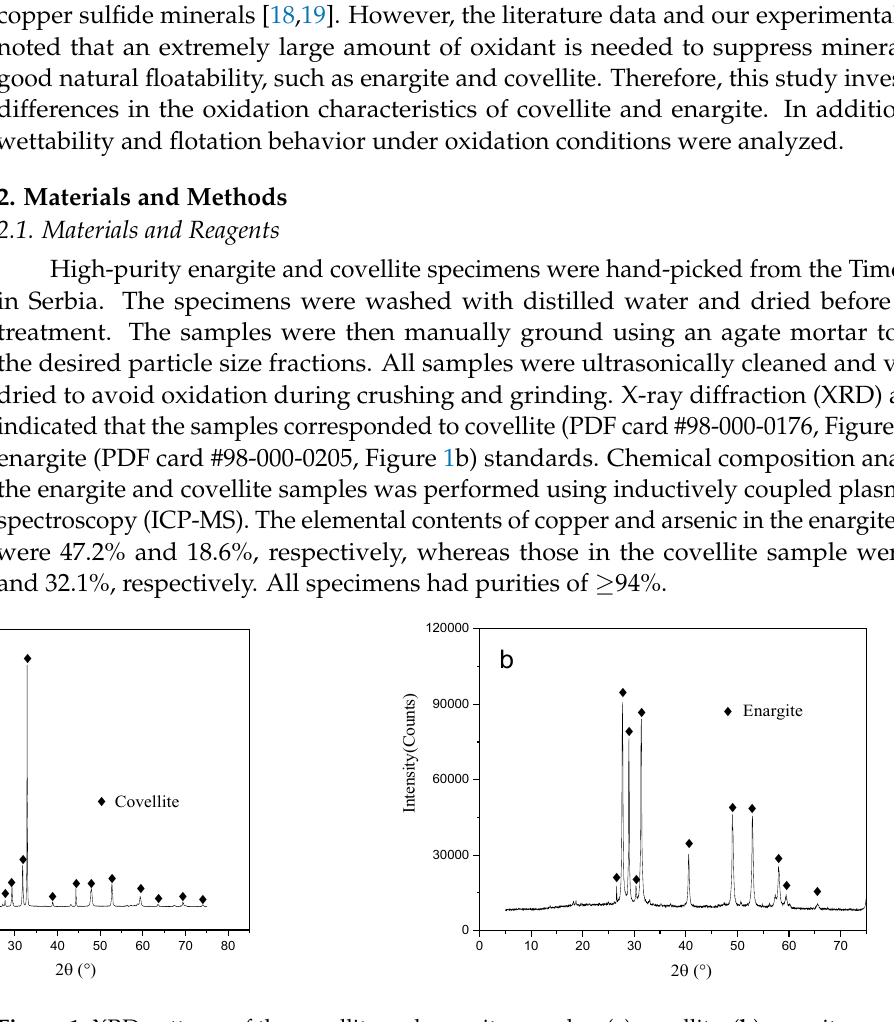
Figure 1. XRD patterns of the covellite and enargite samples: ( a ) covellite, ( b ) enargite.